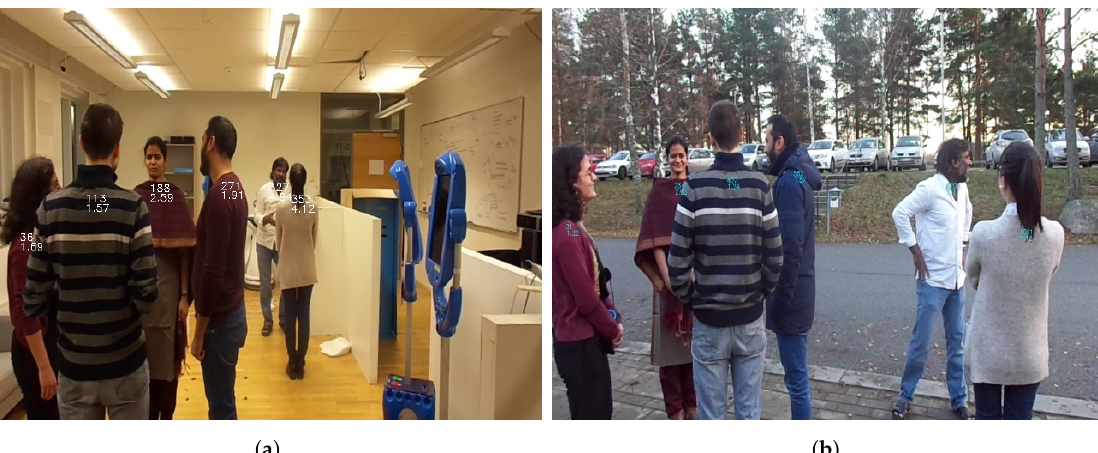
Figure 1. Two sample images of social interactions from an egocentric view with a cluttered background and foreground. Six people are interacting in two groups. Two people, one in each group, are not facing the camera. In ( a ), the estimated location of the torso in the image plane and the observed distance are provided for each person. In ( b ), estimating distance in outdoor environment. The numbers present on the people in the images represent two information’s. The upper number is the location (column number) of the torso of the person in the image. The below number is the distance of the person from the camera in